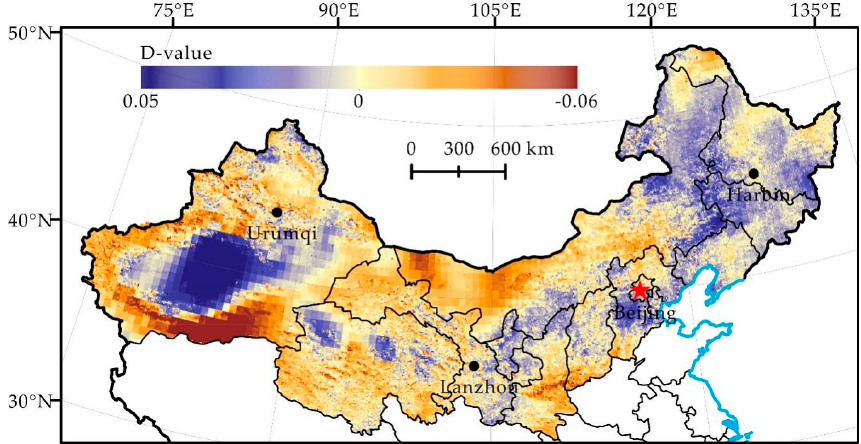
Figure 7. Distribution of Residual Trend Change from 1991 to 2000 (Where D-value positively far away from 0 is a hot spot for land degradation reversal, vice versa, land degradation development.).